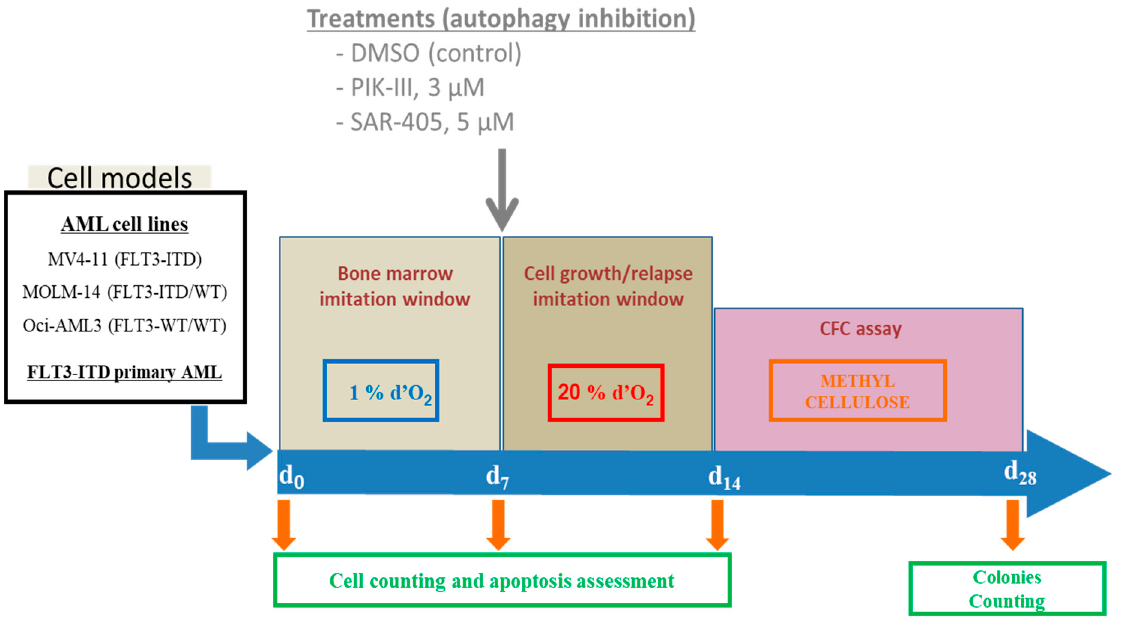
Figure 1. Schematic presentation of experimental procedure. AML cell lines growing were placed at day 0 at 1% O 2 for 7 days. At day 7, cells were counted and apoptosis was quantified by flow cytometry using annexin V labeling. Then, cells were treated or not and placed at 20% O 2 for the next 7 days. Then, cell count and apoptosis were measured before seeding 10 3 cells in a methylcellulose dish. After 14 days, colonies were quantified by microscopy counting in triplicate.